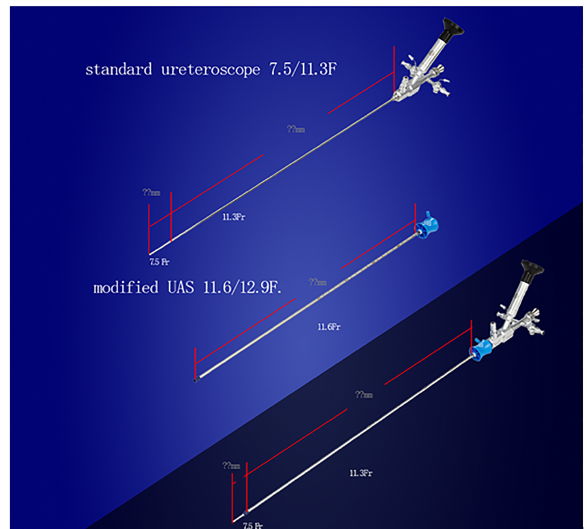
Figure 1 - Standard ureteroscope and modified ureteral access